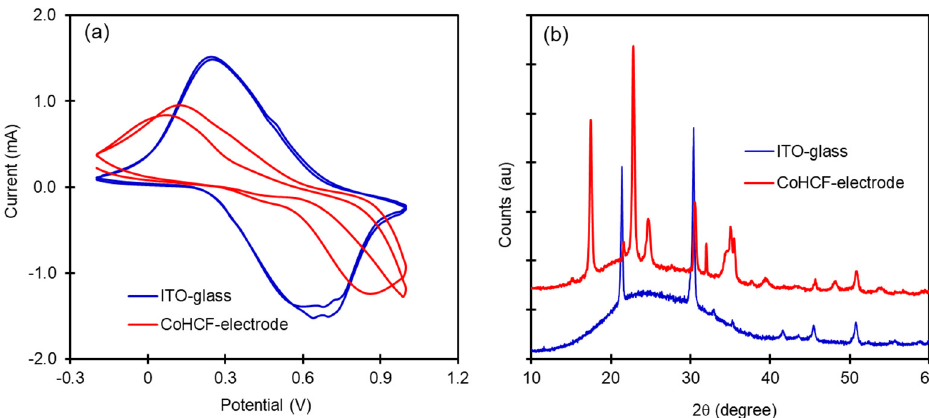
Figure 2. Characterization of CoHCF thin film. ( a ) Cyclic voltammograms of raw ITO glass and that coated with CoHCF thin film vs. Ag/AgCl electrode. Scan rate = 5 mV/s. ( b ) XRD pattern of CoHCF thin film on ITO glass.